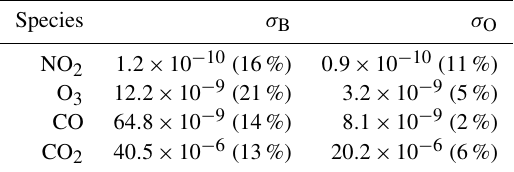
Table 5. Background ( σ B ) and observation ( σ O ) error standard de- viation used in DA experiments expressed in volume mixing ratio units and, within brackets, in percentage of the average field value in Fig.